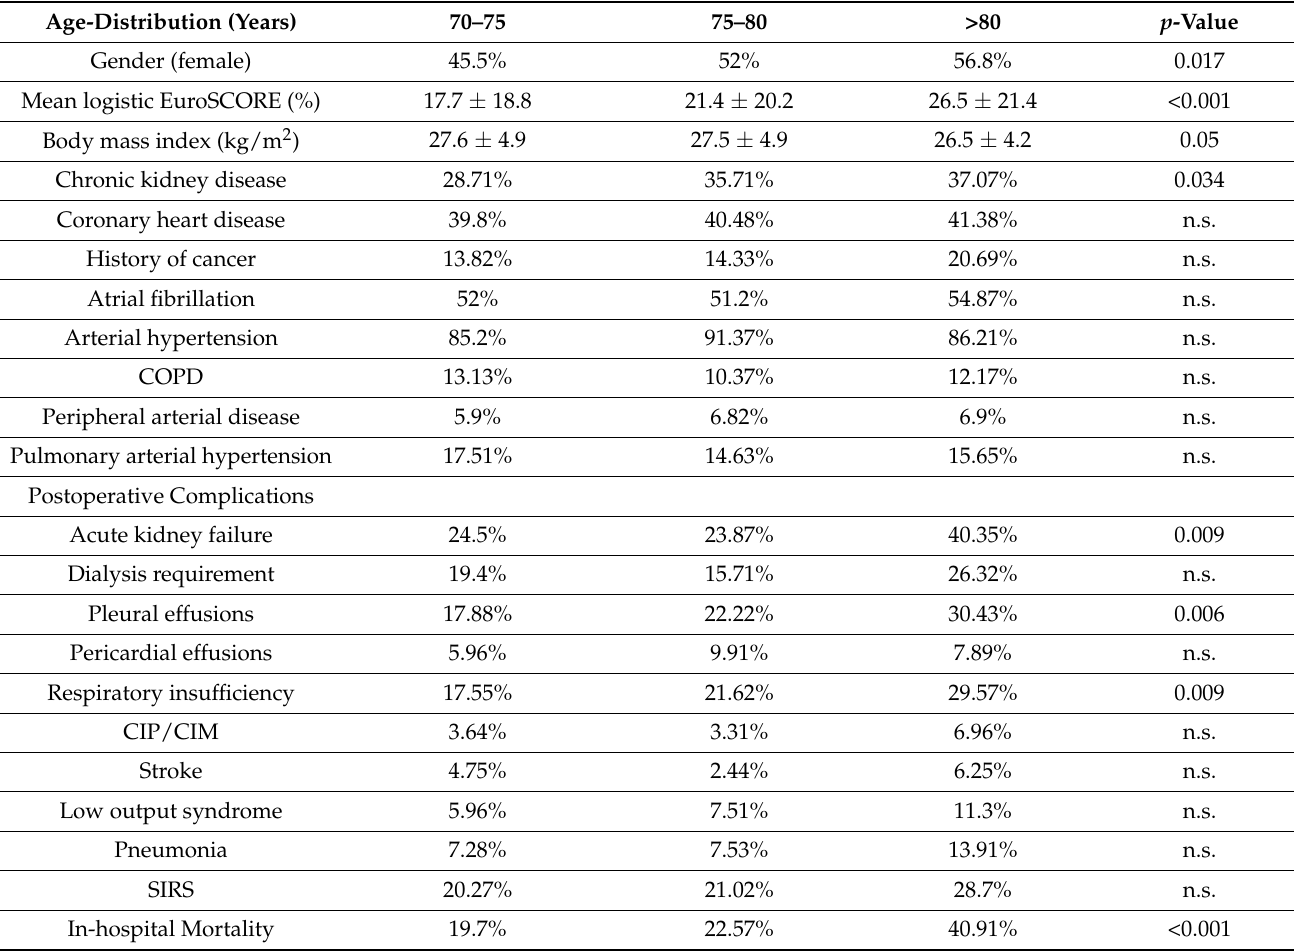
Table 3. Mortality, postoperative complications and comorbidities in advanced